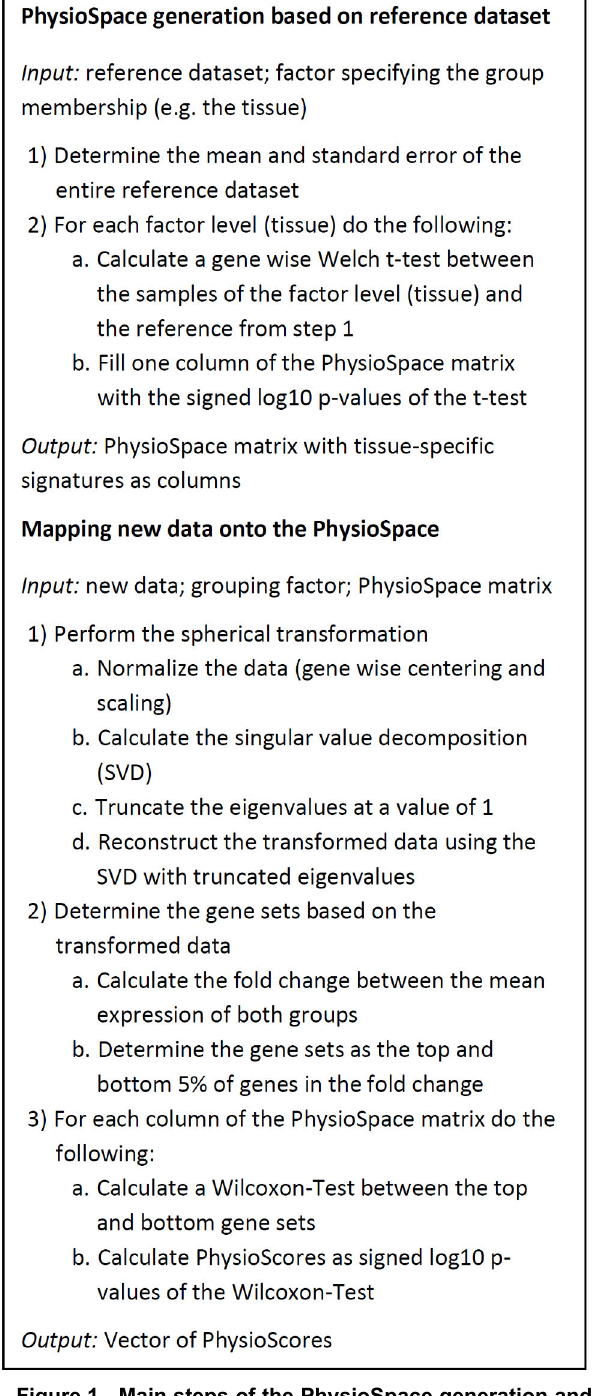
Figure 1. Main steps of the PhysioSpace generation and mapping algorithms.